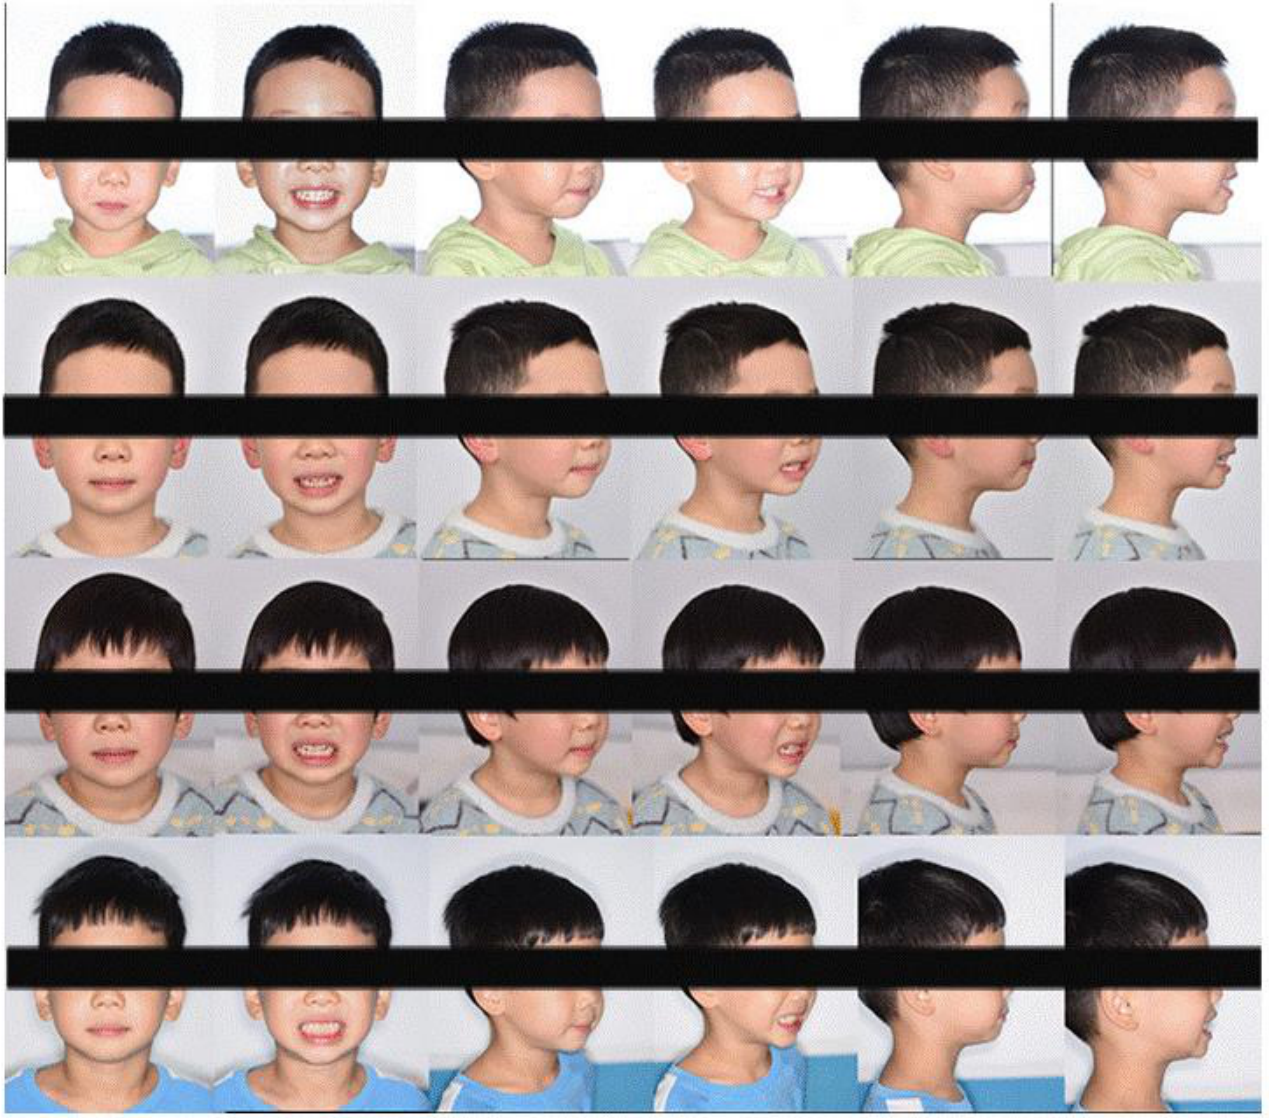
Figure 17. Changes in lateral profile.